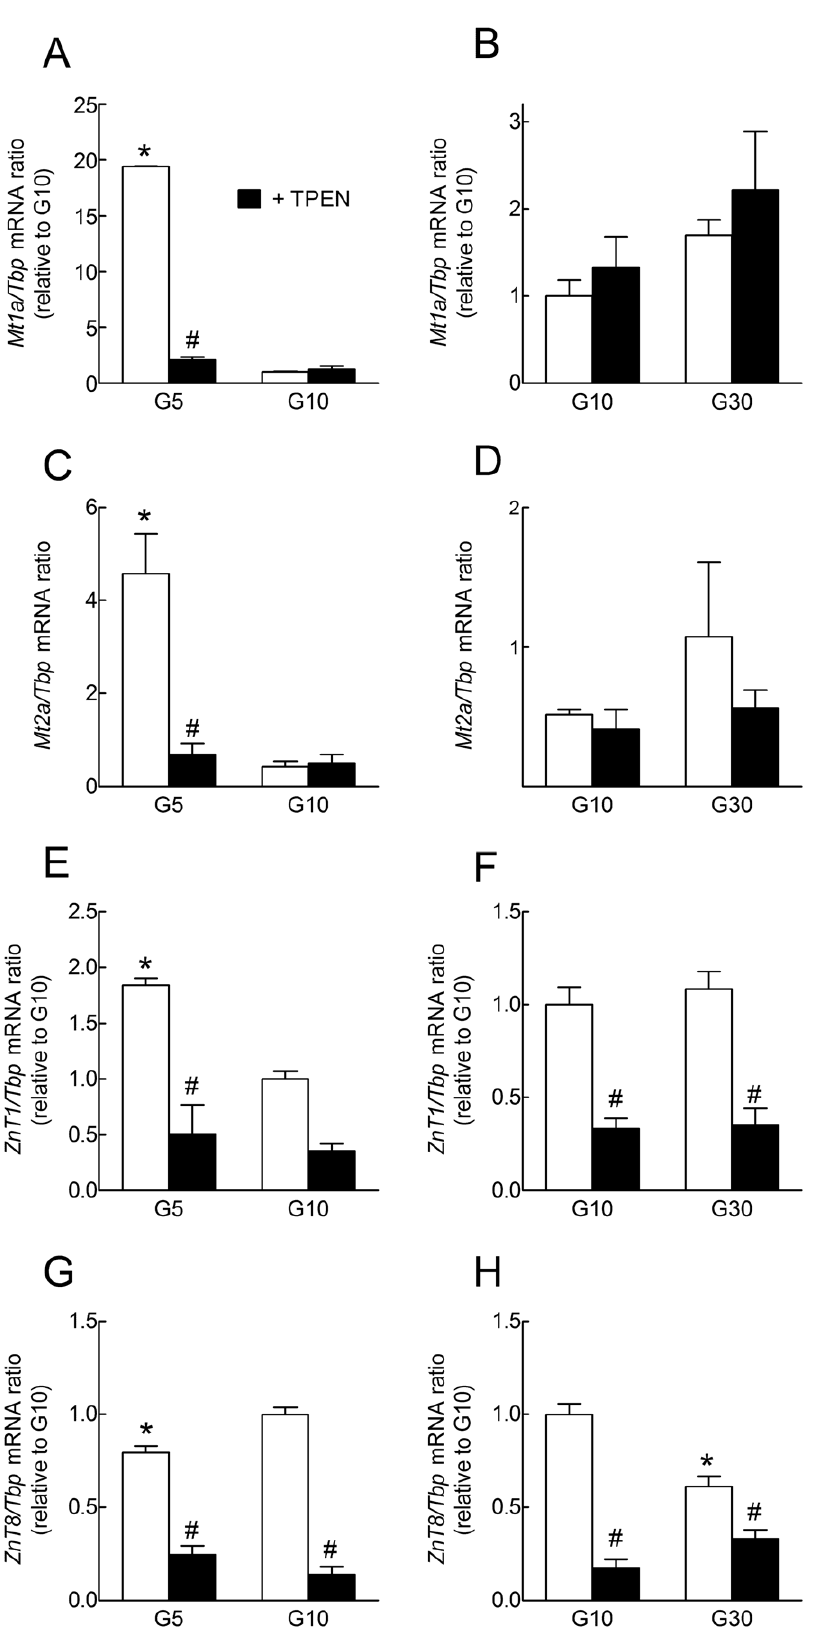
Figure 1. Effects of glucose and Zn 2 + chelation by TPEN on Mt1a,Mt2a,ZnT1andZnT8 mRNA expression in overnight cultured rat islets. Rat islets were precultured for 1 week in serum-free RPMI medium containing G10 and 5 g/l BSA. They were then cultured for 18 h in the